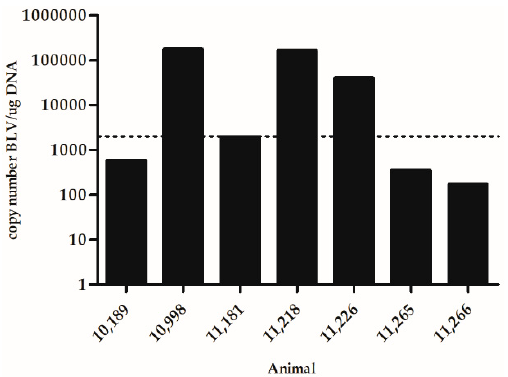
Figure 1. Blood proviral load (PVL) in the peripartum period in cows under study. Dot line corresponds to the threshold between high and low PVL.